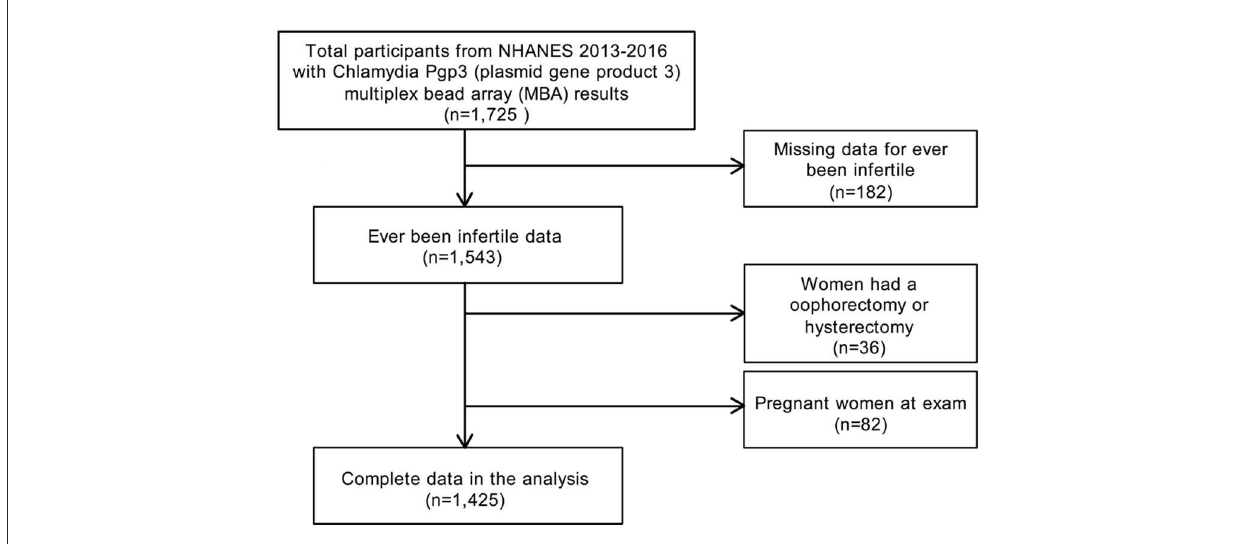
FIGURE1 Flow chart of participant selection from the NHANES 2013–2016.